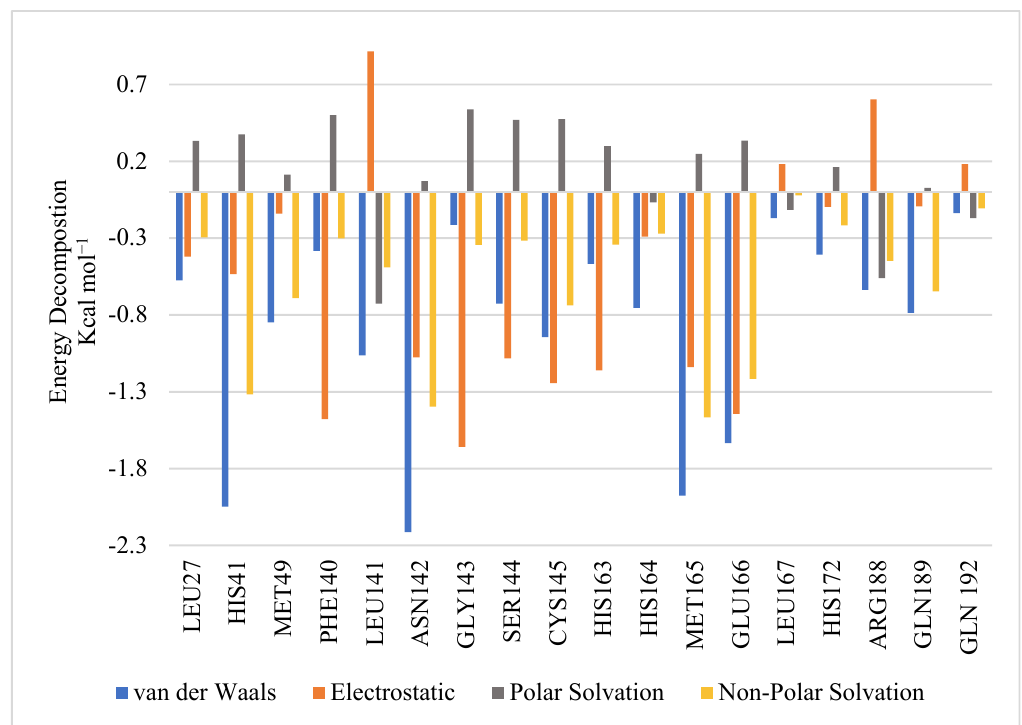
Figure 10. Pairwise energy decomposition graph illustrating residue contributions to protein-ligand (GR20) complex.